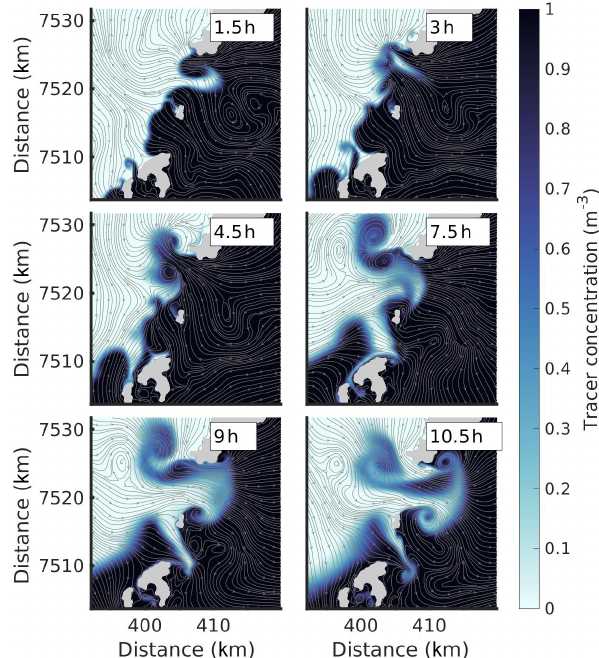
Figure 10. Same as Fig. 9 but for Moskstraumen (3) and Nordlands- flaget